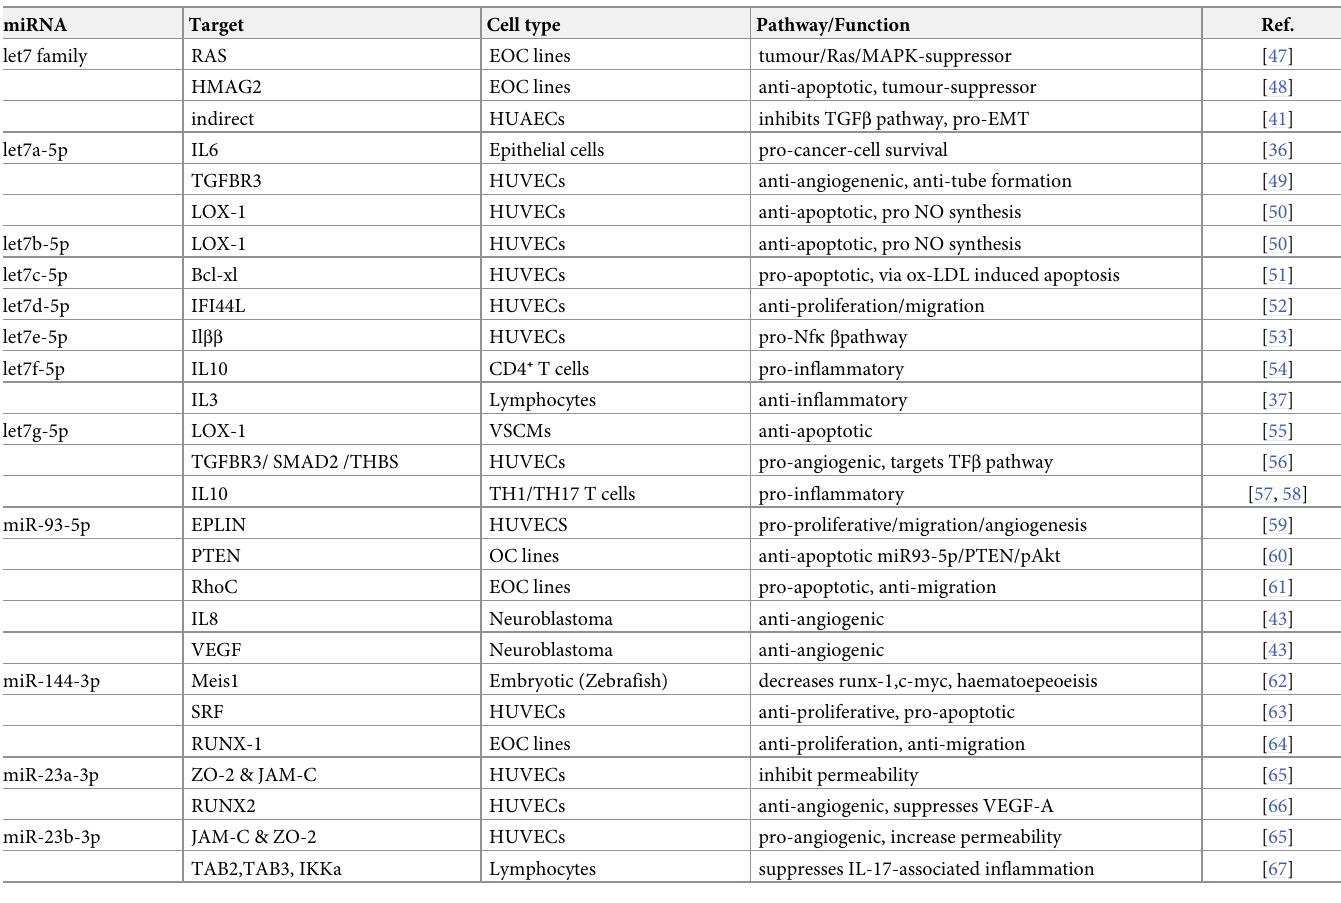
Table 9. Confirmed targets of miRNA in primarily endothelial and cancer cell lines identified as significantly differentially regulated between groups.